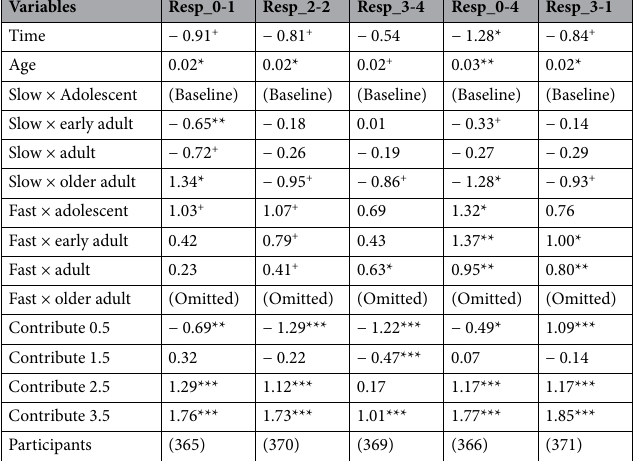
Table 13. Ordered probit specification (3) but with informed contributions as dependent variables. + p < 0.15 (marginally significant), *p < 0.05, **p < 0.01, ***p <